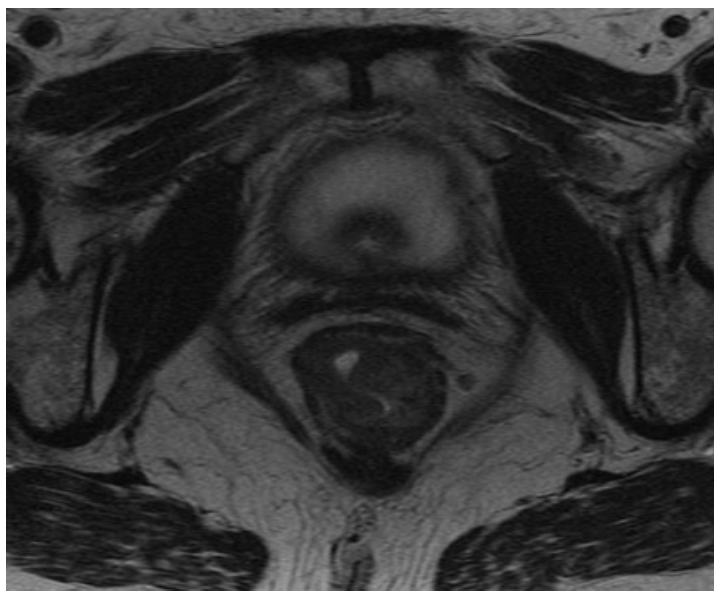
Figure 2. EMVI-negative rectal cancer.